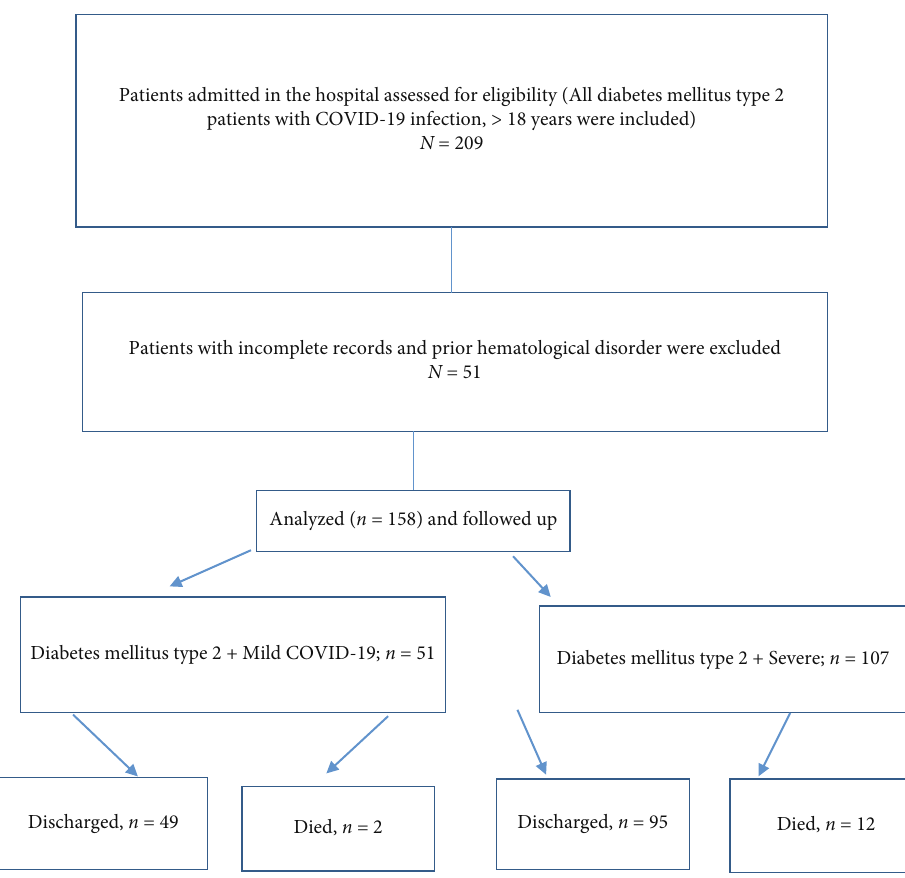
Figure 1: Recruitment and assessment fl owchart for